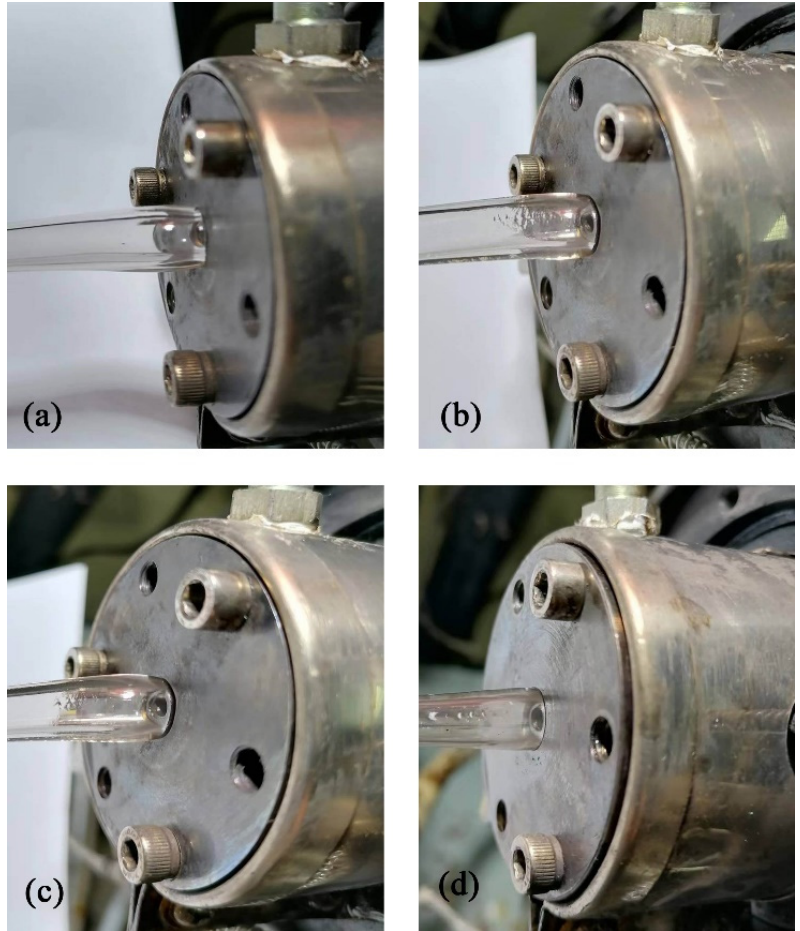
Figure 11. Results of micro-tube extrusion experiment. ( a ) The non-gas-assisted extrusion process; ( b ) Outer gas pressure = 6500 Pa; ( c ) Outer gas pressure = 7500 Pa; ( d ) Outer gas pressure = 10,000 Pa.